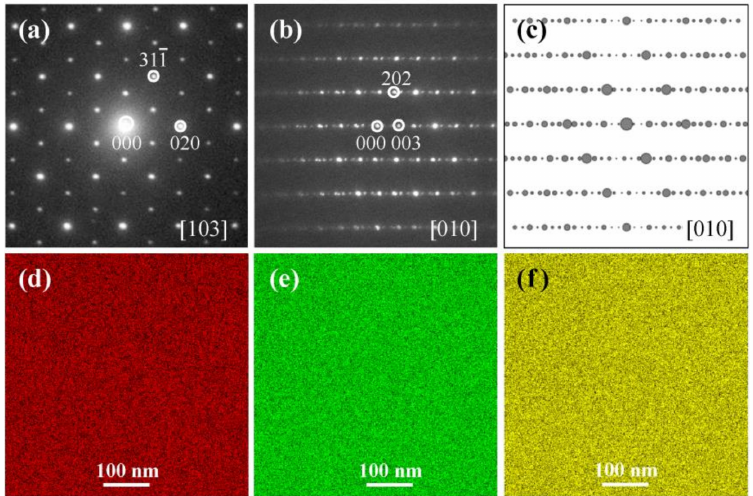
Figure 2. Selected area electron diffraction (SAED) patterns of Bi 2 TeI along the zone axis of ( a ) [103], ( b ) [010], and ( c ) simulated SAED pattern along [010] zone axis. Elemental mapping of ( d ) Bi, ( e ) Te, and ( f ) I of Bi 2 TeI measured by Scanning transmission electron microscopy–energy dispersion X-ray spectroscopy (STEM-EDX).